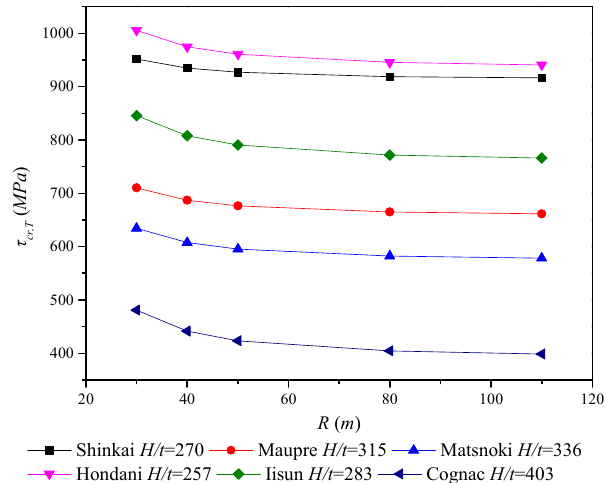
Figure 13. Global elastic shear buckling strength of PCCSW in theory τ cr,T versus curvature radius R.